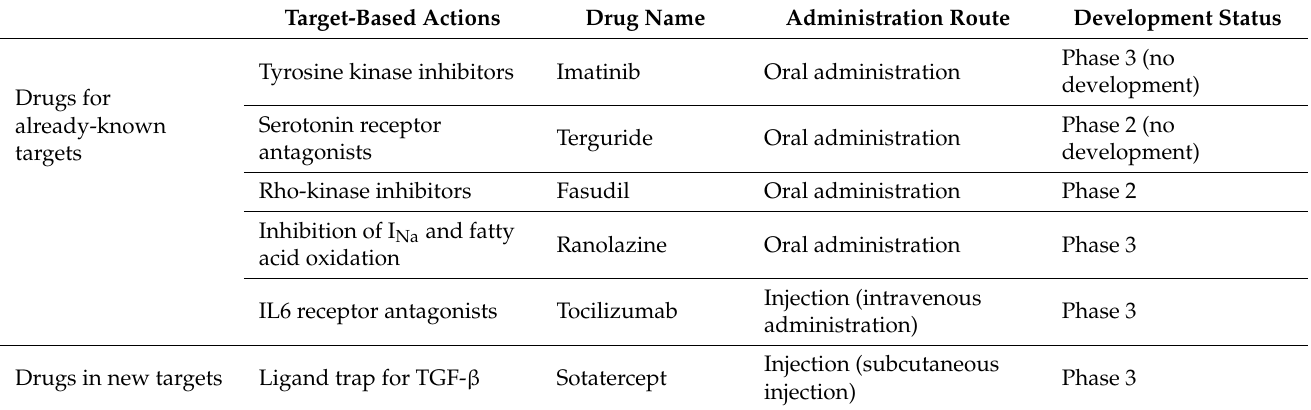
Table 2. Development of new drugs for